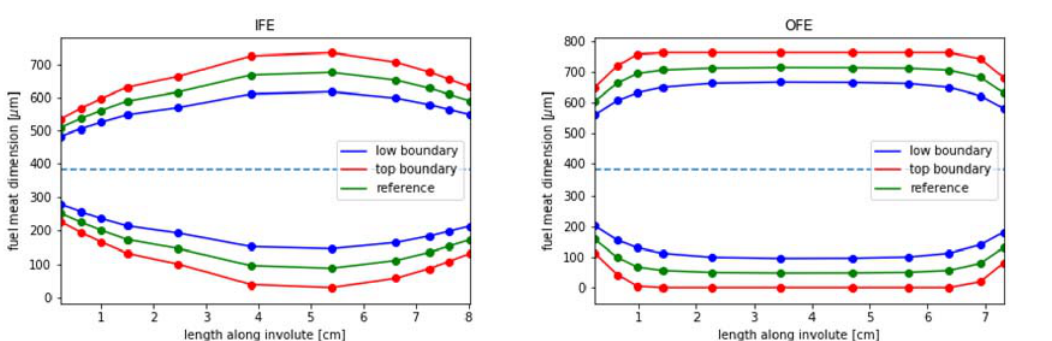
FIGURE 3. The Upper and Lower Bounds for the Optimization of Fuel Shape Were 110% and 90% of the Discrete Fuel Thickness Points of the Reference Fuel Shape,